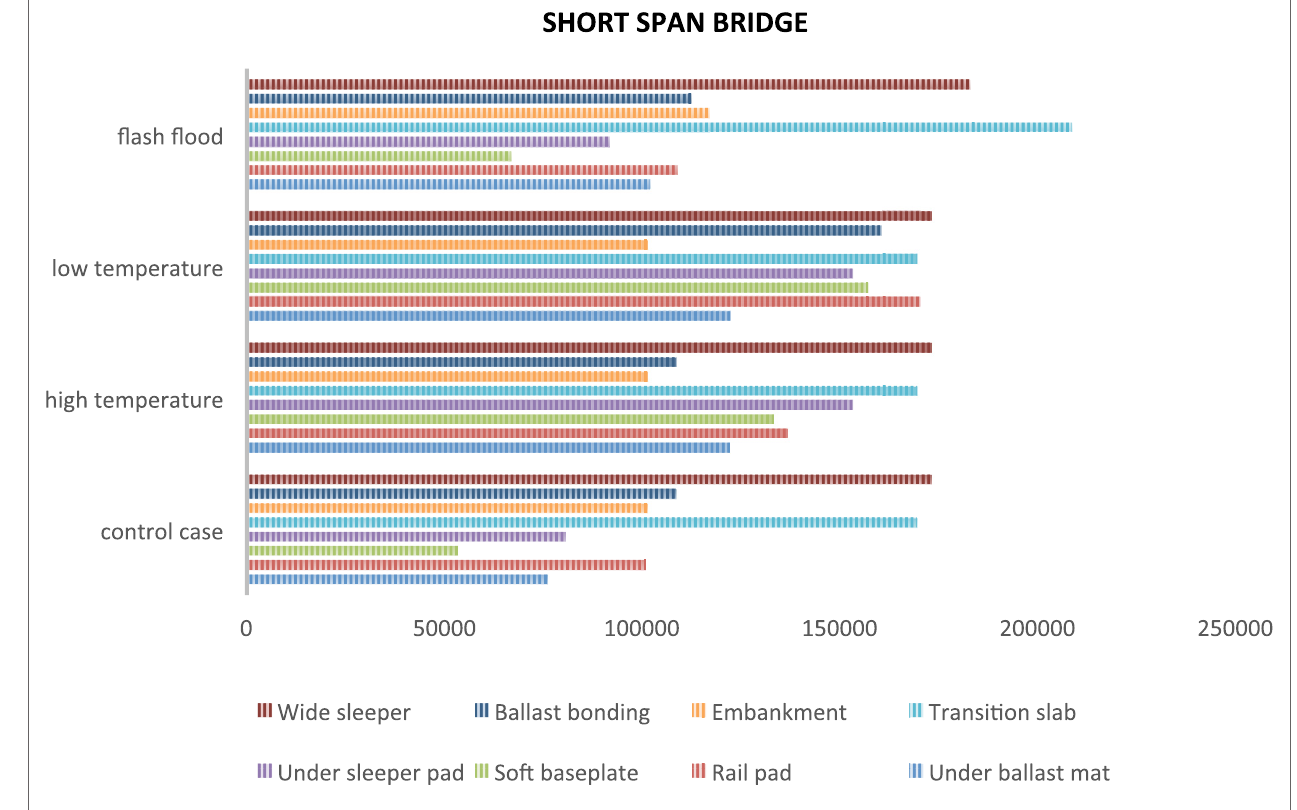
Figure 4 | Net present value (NPV) of total cost of bridge approach treatment methodologies for short-span bridge in four